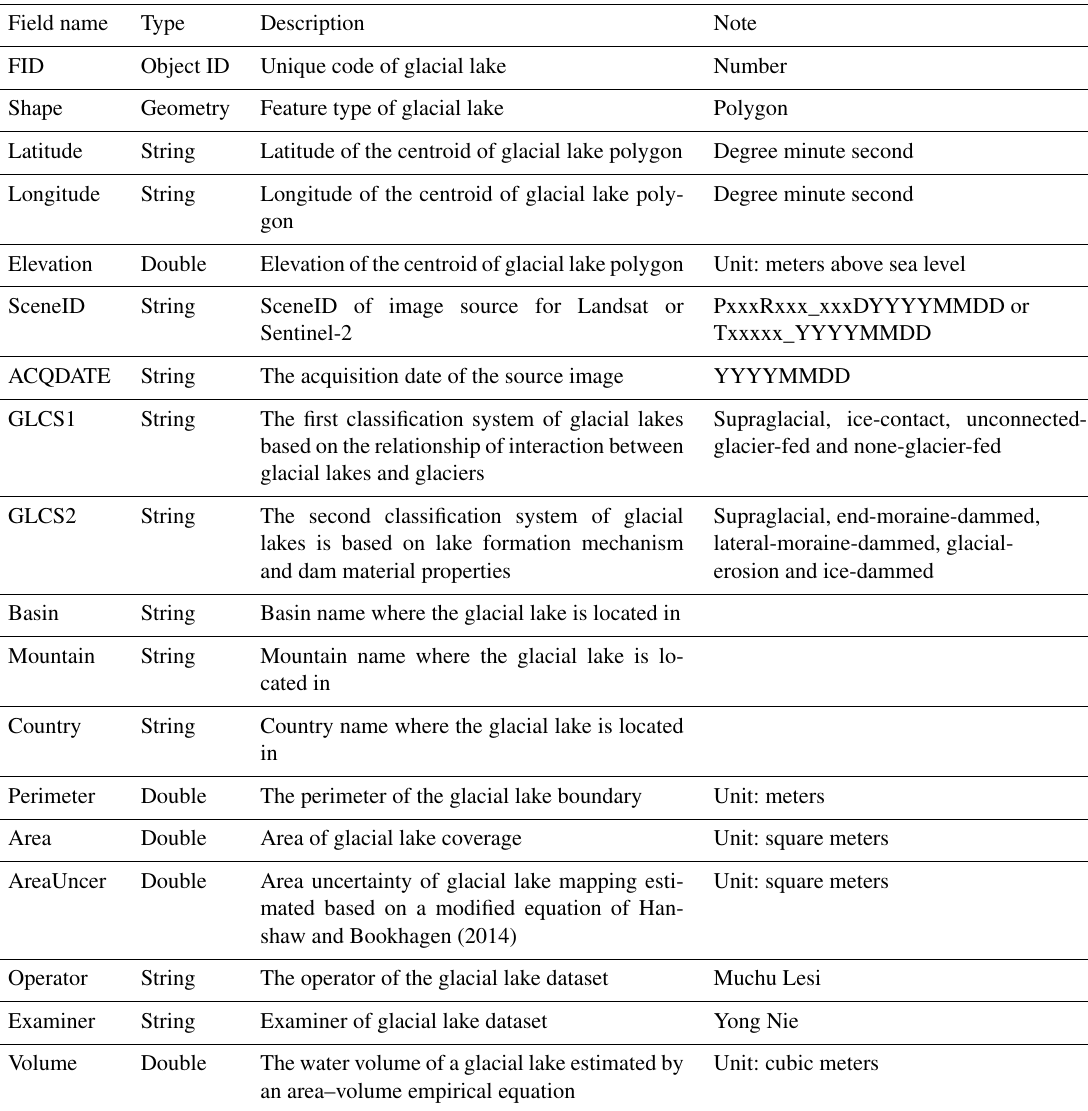
Table 3. Attributes of glacial lake